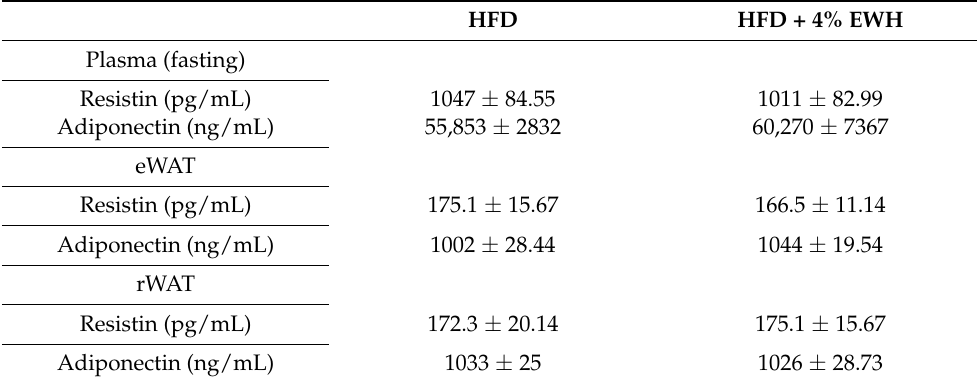
Abbreviations: HFD, high fat diet; EWH, egg white hydrolysate; eWAT, epididymal adipose tissue; rWAT, retroperitoneal adipose